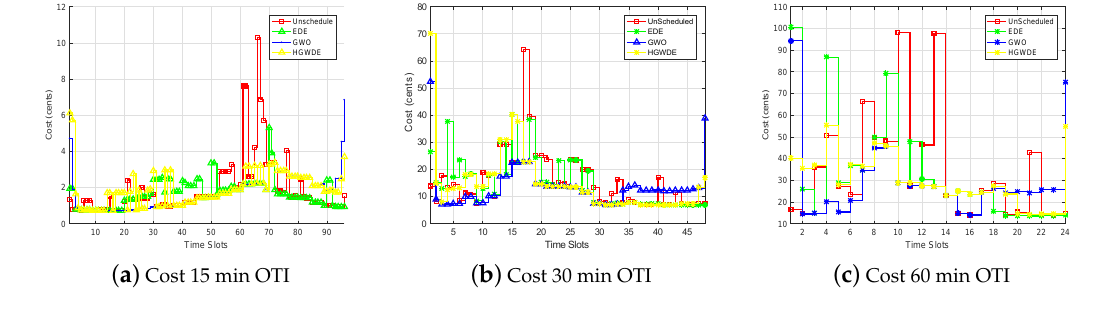
Figure 3. Cost per time slot for RTP.